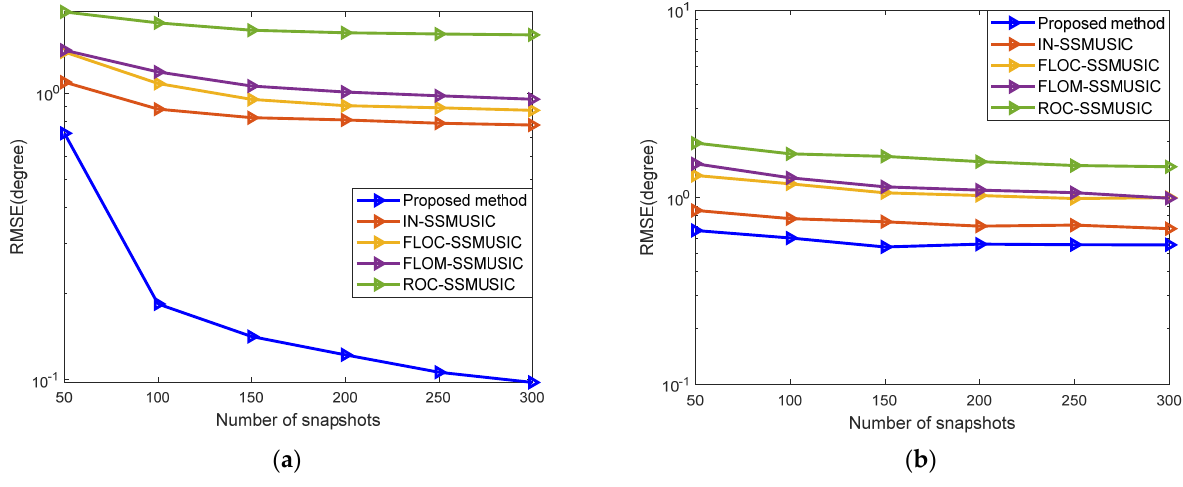
Figure 6. Influence of the number of snapshots on the performance of the algorithm: ( a ) GMM noise; S S α ( b ) noise. ( b ) S α S